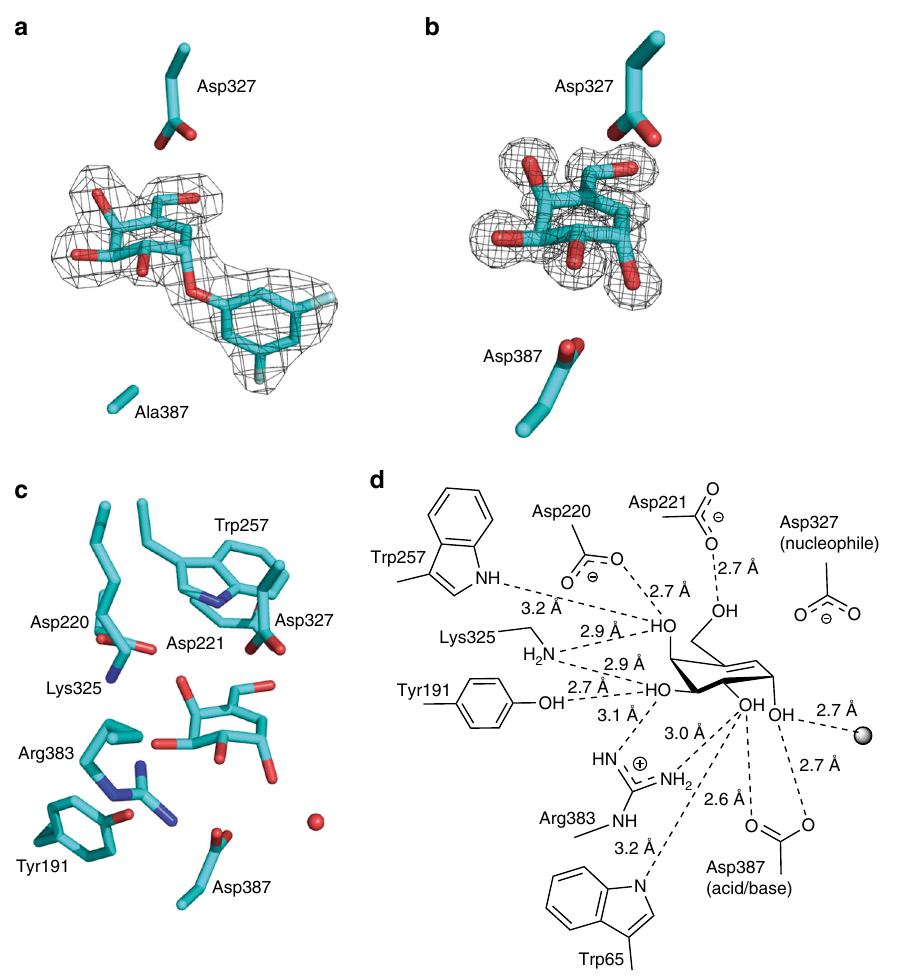
Fig. 5 Structure of Tm GalA in complex with 3a and 5 . a Structure of Tm GalA mutant D387A in complex with intact 3a . b Structure of Tm GalA in complex with hydrolyzed inhibitor 5 . The maximum likelihood/ σ A weighted 2 F obs − F calc electron density map is contoured at 1.2 sigma in a and 2 sigma in b . The catalytic residues D327 and D387 (or D387A) residues are shown. c , d Structure of Tm GalA in complex with hydrolyzed inhibitor 5 illustrating active site residues that hydrogen bond with the inhibitor. The red sphere in c and gray sphere in d represent a water